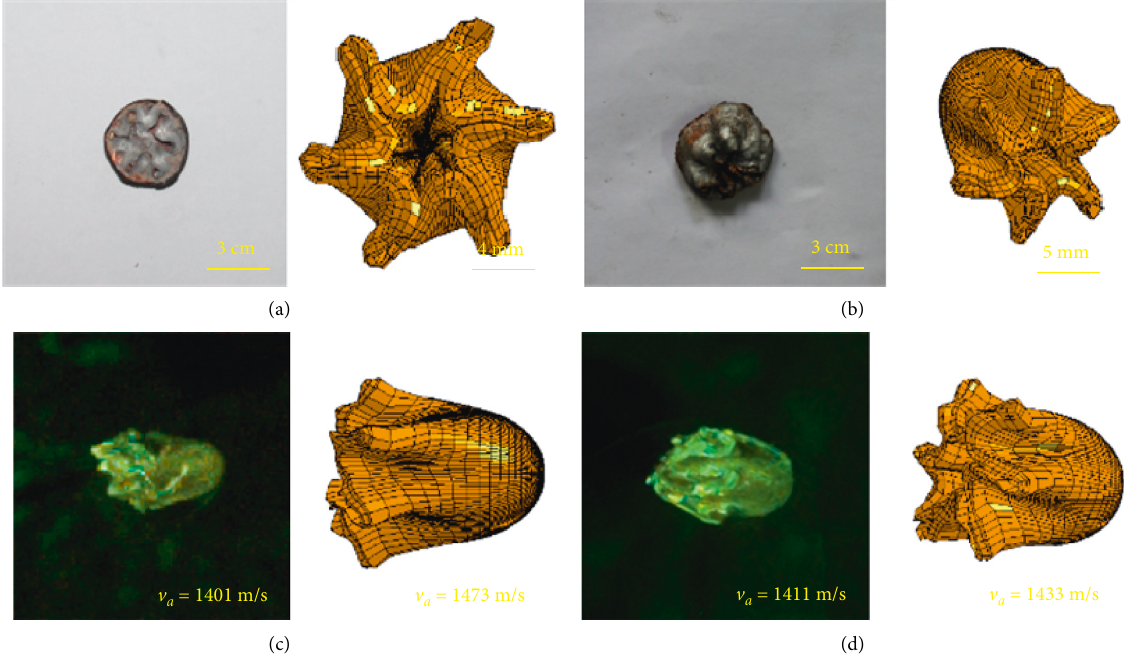
Figure 15: Comparison between the experiments and the simulation: EFP formation tests. (a) A-1# and (b) A-4#; EFP trajectories and impacts (c) B-2# and (d) B-5#.